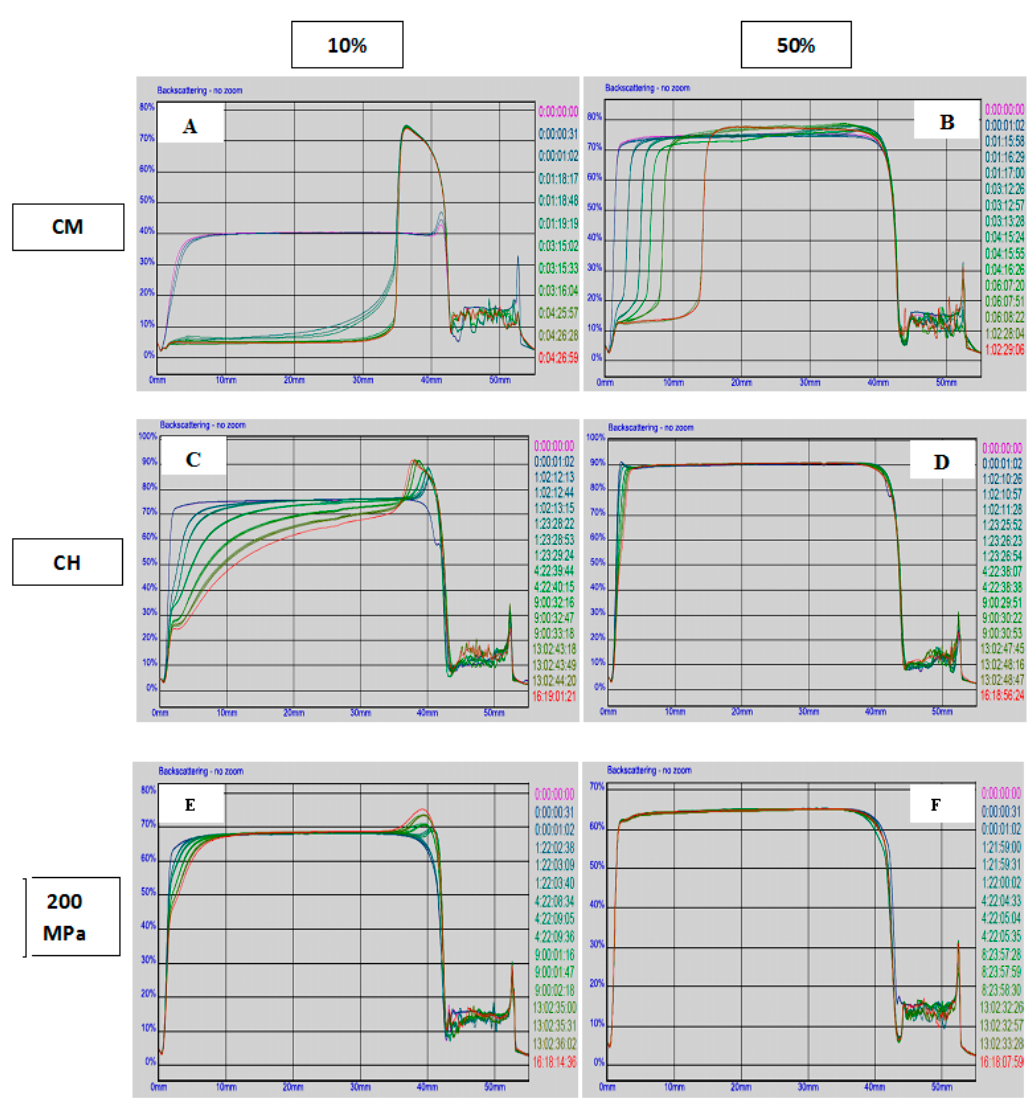
Figure 4. Changes in backscattering profiles (BS%) ( A – F ) of emulsions containing 4% of WPI